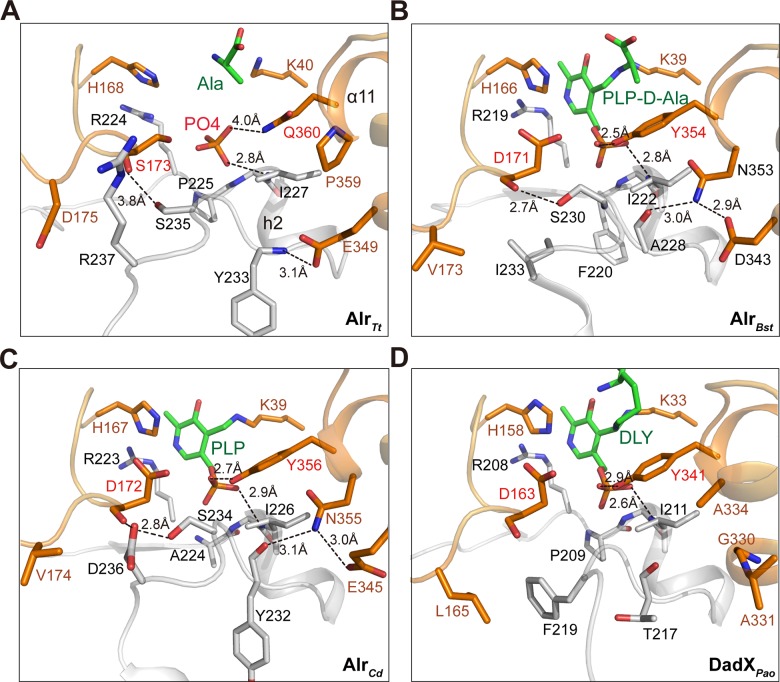
The hydrophobic patch and its interaction with active site pocket.
(A) The hydrophobic patch (Pro225-Arg237) in AlrTt (PDB 4Y2W) is colored in gray, the active site pocket is shown in orange, the substrate and key amino acids mediating the interactions are shown in sticks, the hydrogen bonding interactions are indicated. The hydrophobic patch and active site pocket of the other three bacterial alanine racemases are shown in same view: (B) the PLP-D-Ala complex of AlrBst (PDB 1L6G). (C) PLP complex of AlrCd (PDB 4LUS), (D) PLP and DLY complex of DadXpao (PDB 1RCQ).